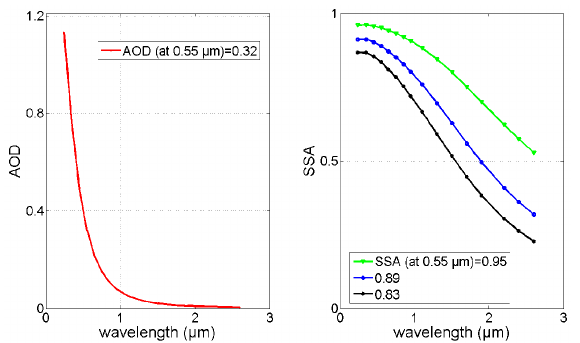
Fig 12 764 Fig. 12. The difference of aerosol forcing efficiency derived from averaging the results shown in Fig. 11 over the six Amazonian veg- etation types. Bars represent the standard deviation of the aerosol forcing efficiency differences among the six vegetation types. The labels on the x-axis denote different methods to estimate vegeta- tion reflectance spectrum used in the aerosol forcing calculation. The curves in green, blue, and red represent the results for differ- ent aerosol models: SSA (at 0.55µm)=0.95, 0.89, and 0.83. Other parameters used include AOD (at 0.55µm) of 0.32 and SZA of 30 degrees.